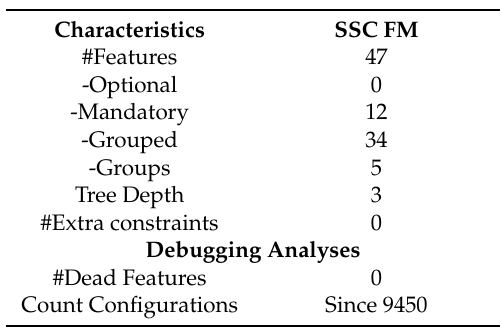
Figure 8. SSC implementation-level concrete feature model. Table 3. Basic metrics of the SSC feature model taken from the tool SPLOT.